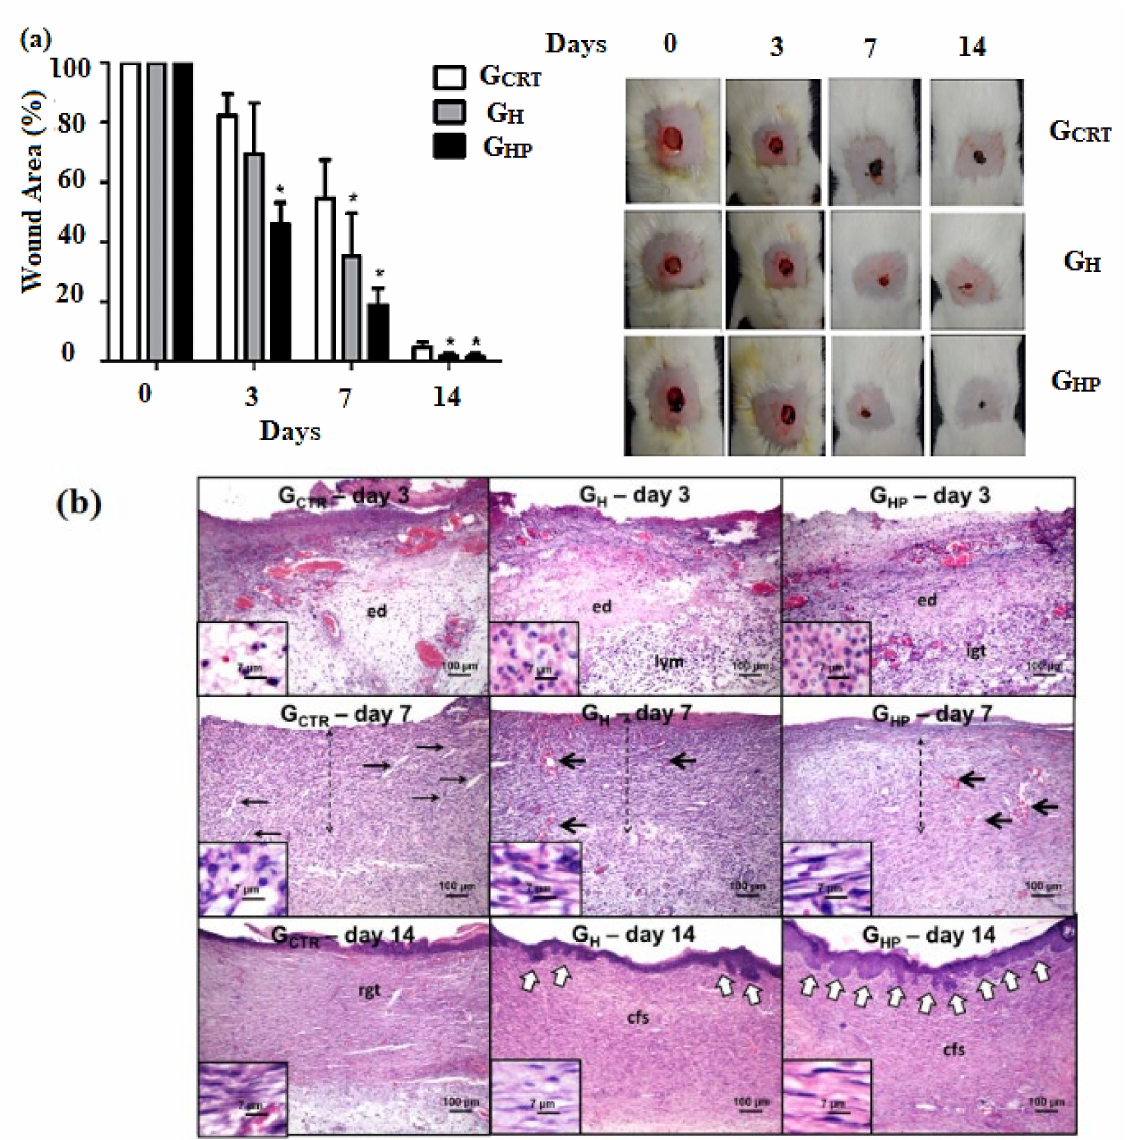
Figure 7. ( a ) Wound surface percentage for: Control Group (G CTR ), group with hydrogel sodium alginate/gelatin (80:20) (G H ), and group hydrogel with AgNP 4 mM AgNO 3 (G HP ) with mean ± S.E. * p < 0.05 in relation to G HP , G CTR and G H , respectively ( n = 21/group). ( b ) Photomicrographs of histological sections stained with hematoxylin/eosin (scale = 100 µ m)